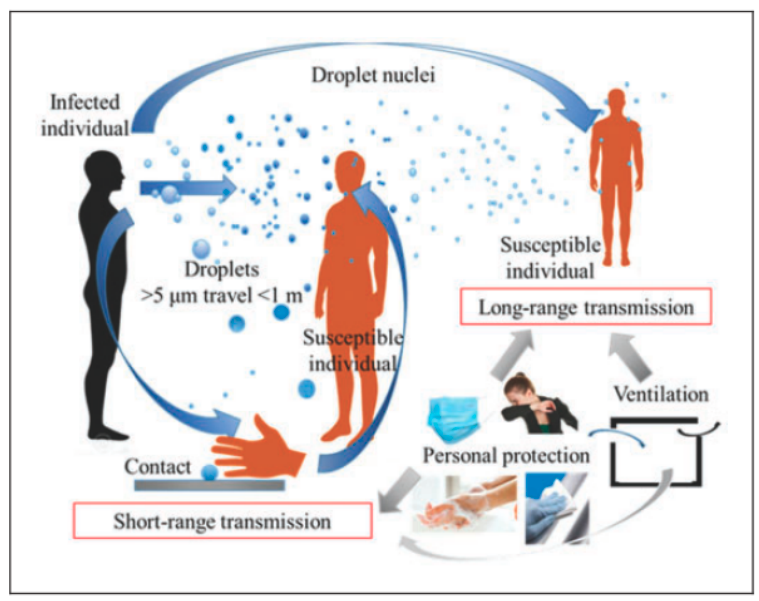
Figure 3. The droplet transmission of SARS-CoV-2 with particles >5 µm [9].